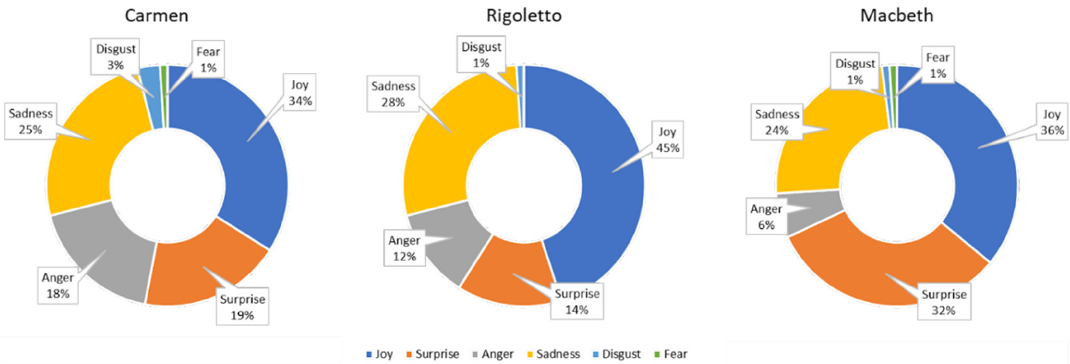
Figure 3. Ekman’s emotions registered during all the monitored performances of the three operas.